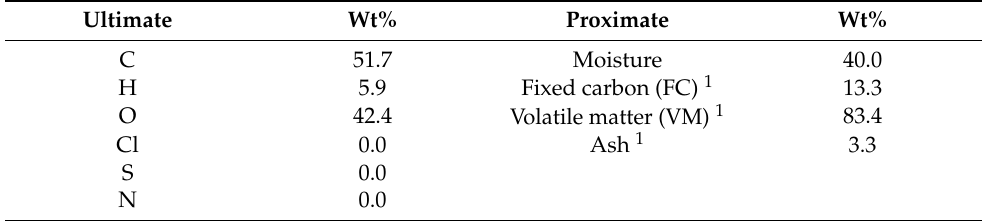
Table 2. Ultimate and proximate analysis (wt.%) of PEFB used for Aspen Plus simulation.